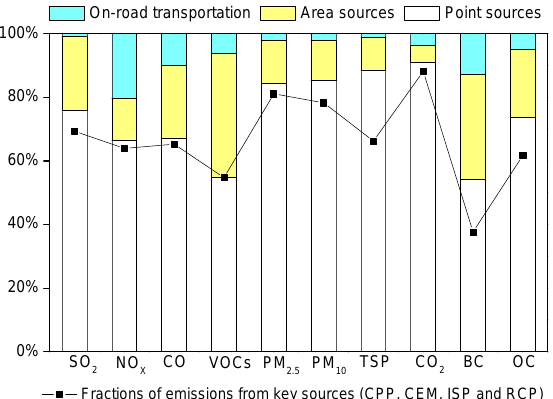
Figure 3. The emission fractions of point sources, area sources, and on-road transportation, and those of key sources of total emissions in Nanjing,